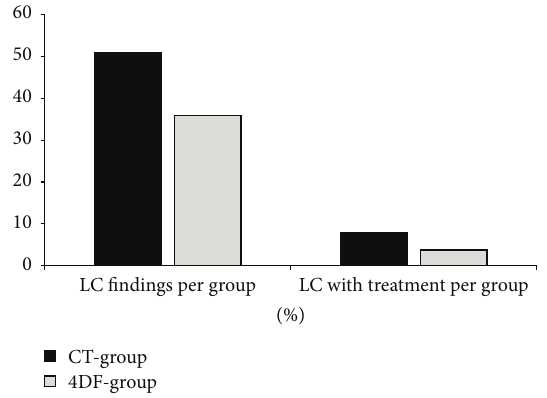
Table 5: Results